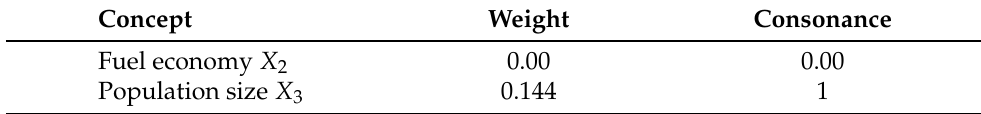
Table 1. Minimum solution to the inverse problem in the transportation system.